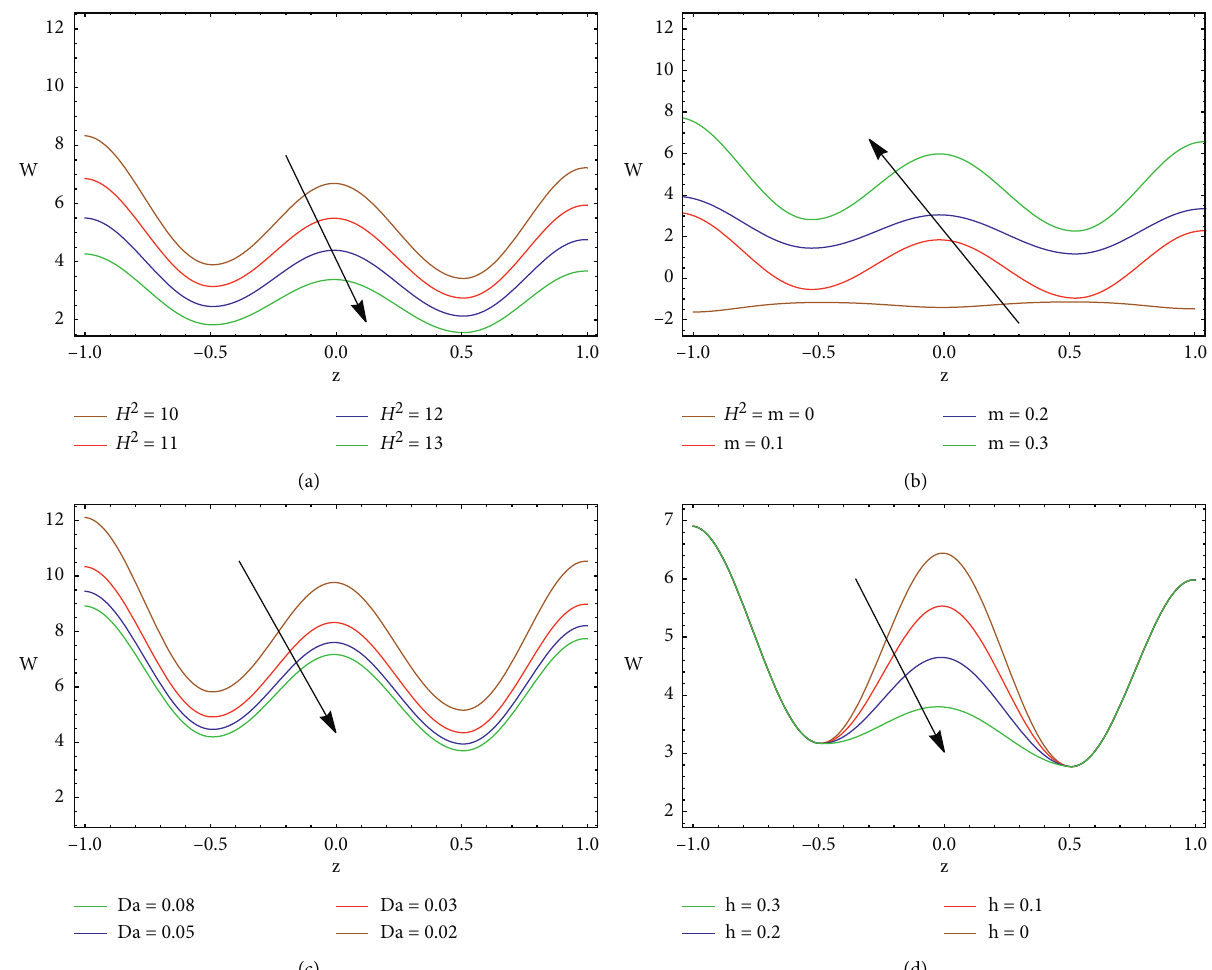
Figure 2: The variation of the axial velocity w ( z ) for different values of H 2 , m , D